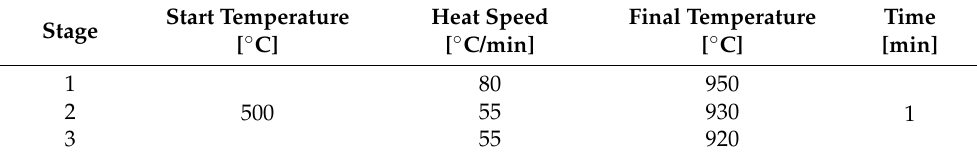
Table 2. Conditions of the porcelain fused to metal